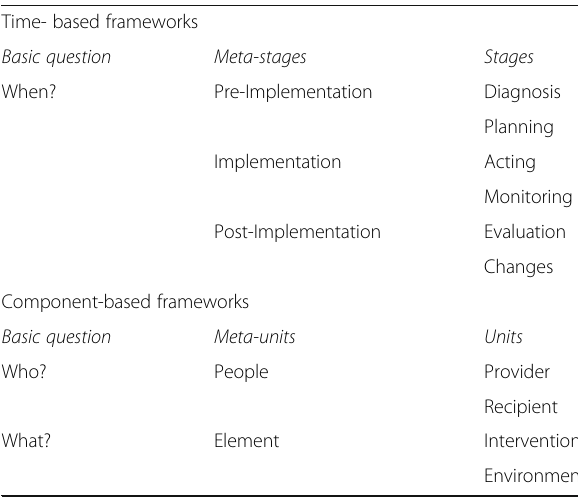
Table 2 Classification of implementation science conceptual